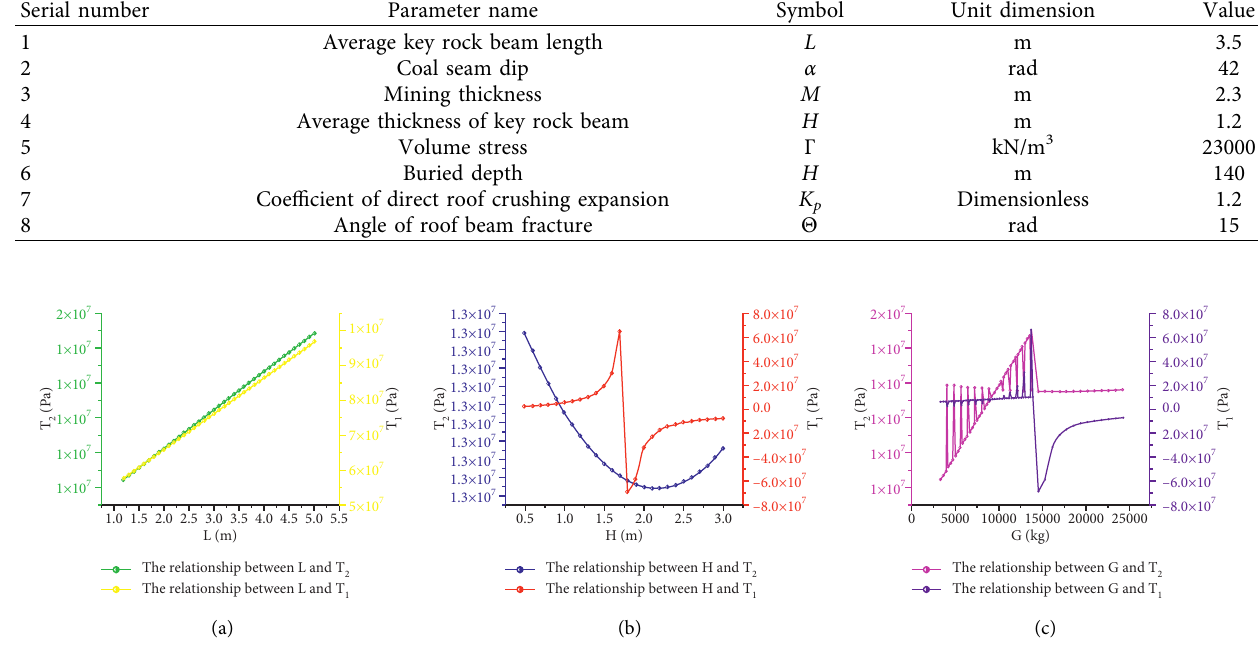
Figure 4: Relationship between geometric physical characteristics of key blocks and strata behavior of working face in steeply dipping coal seam. (a) The relationship between key block length L and T 1 and T 2 . (b) The relationship between the thickness H of the key block and T 1 and T 2 . (c) The relationship between the weight G of key blocks and T 1 and T 2